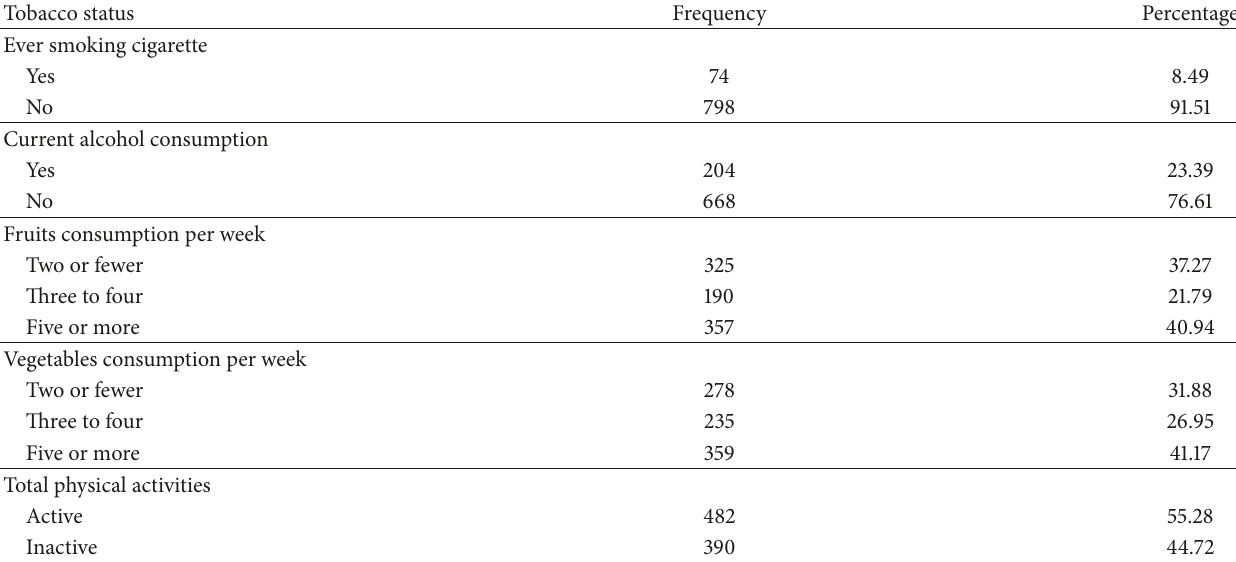
Table 2: Distribution of adults’ behavioral characteristics in Dire Dawa, 2017.